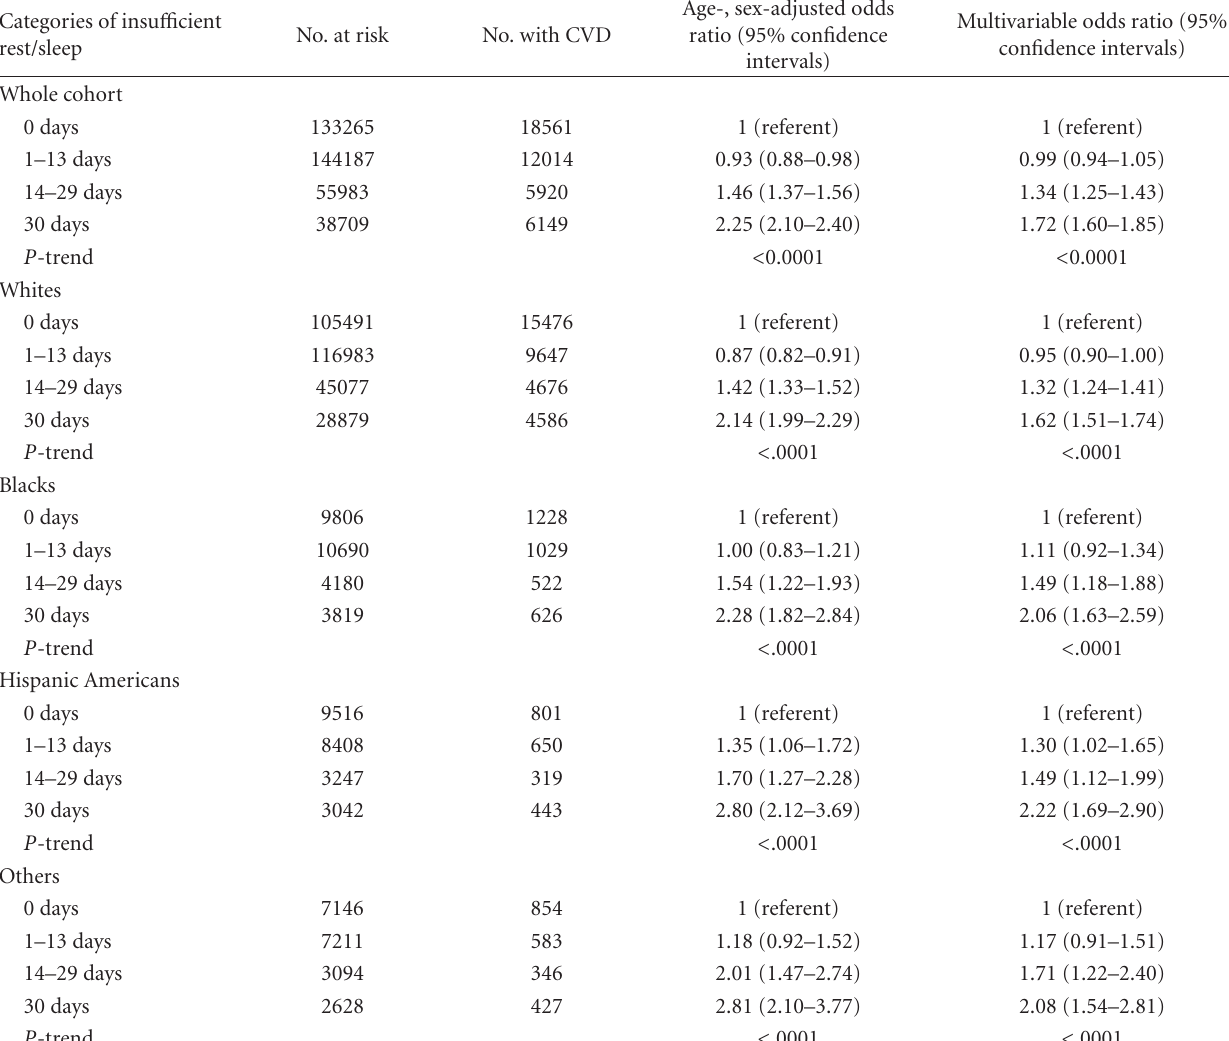
Table 2: Association between insu ffi cient rest/sleep and any cardiovascular disease